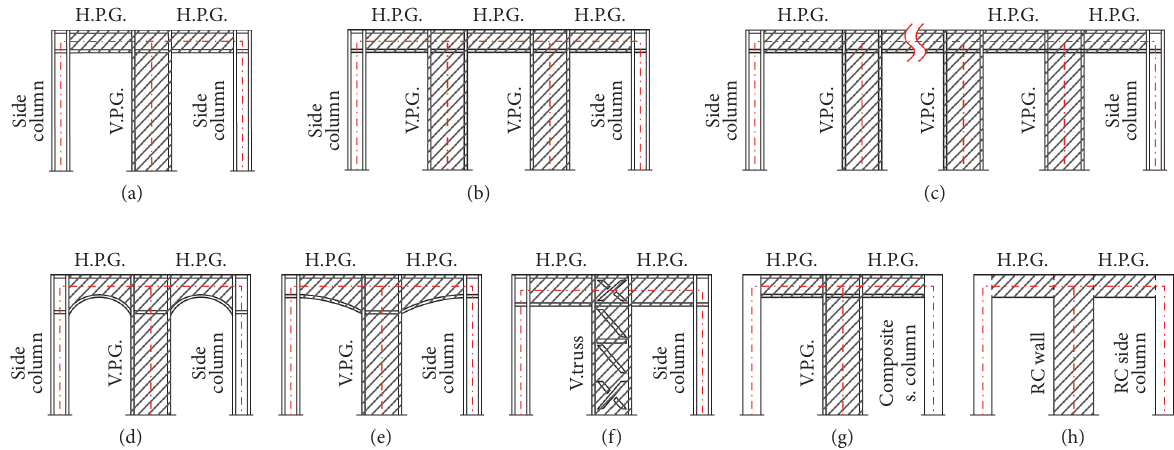
Figure 1: Proposed basic structural configurations of TRF and alternatives [1]. (a) Single-T configuration of TRF. (b) Double-T con- figuration of TRF. (c) Multi-T configuration of TRF. (d) Stylish single-T configuration of TRF. (e) Stylish single-T configuration of TRF. (f) Single-T configuration of TRF using vertical truss. (g) Single-T configuration of TRF using composite side columns. (h) Single-T configuration of reinforced concrete